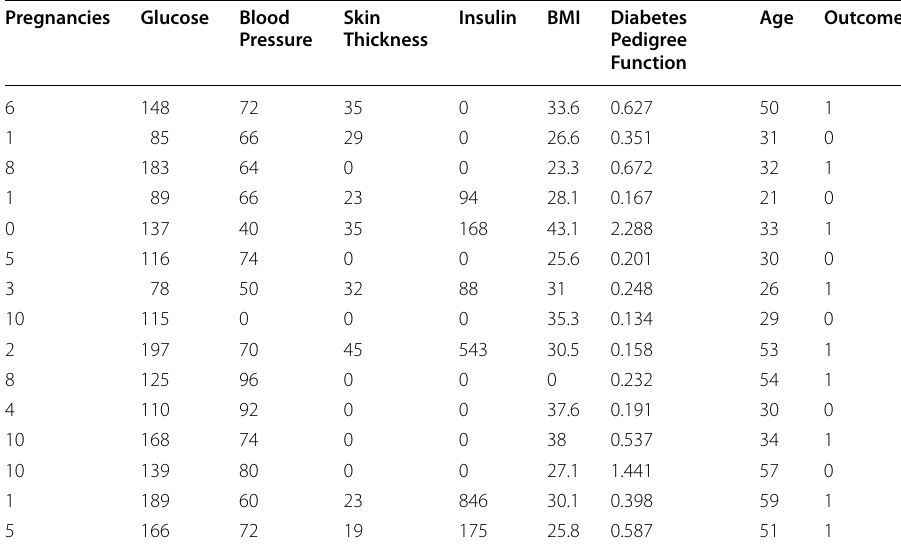
Table 1 15 Rows of the PIMA Dataset